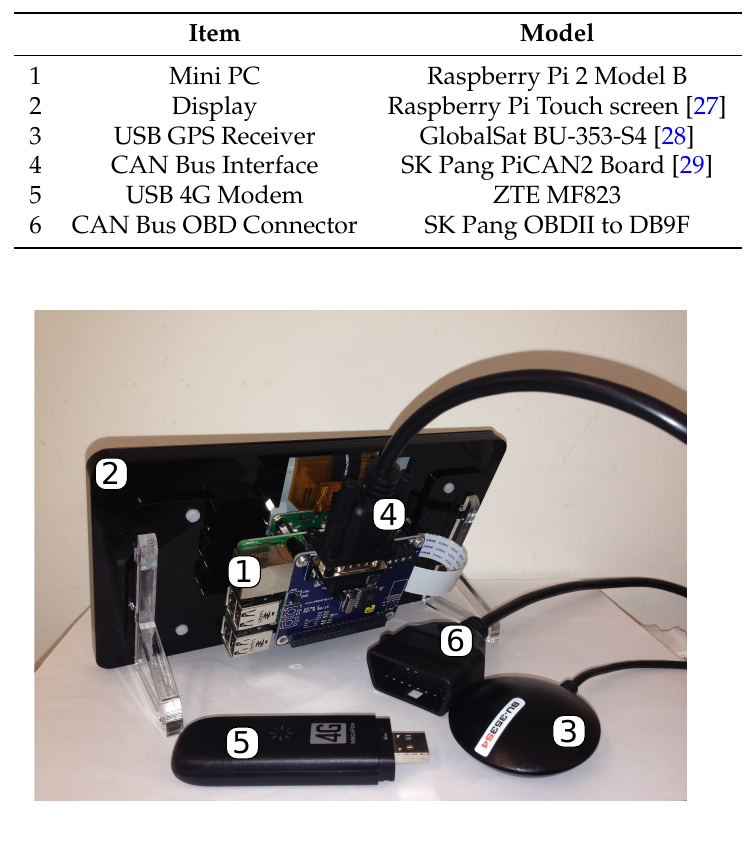
Figure 4. Hardware component